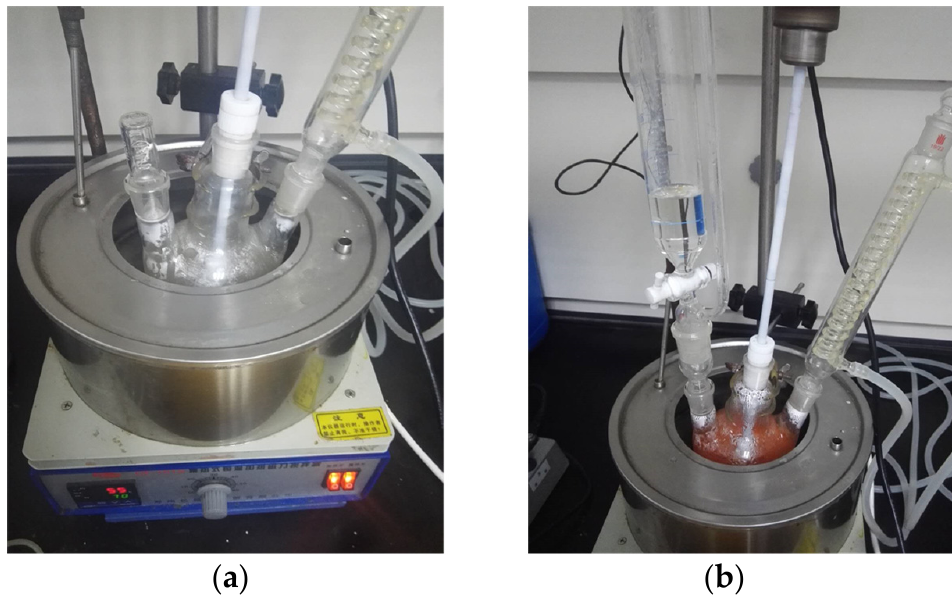
Figure 1. Illustration of curing agent synthesis setup. ( a ) Synthetic reaction equipment. ( b ) Synthetic curing agent.